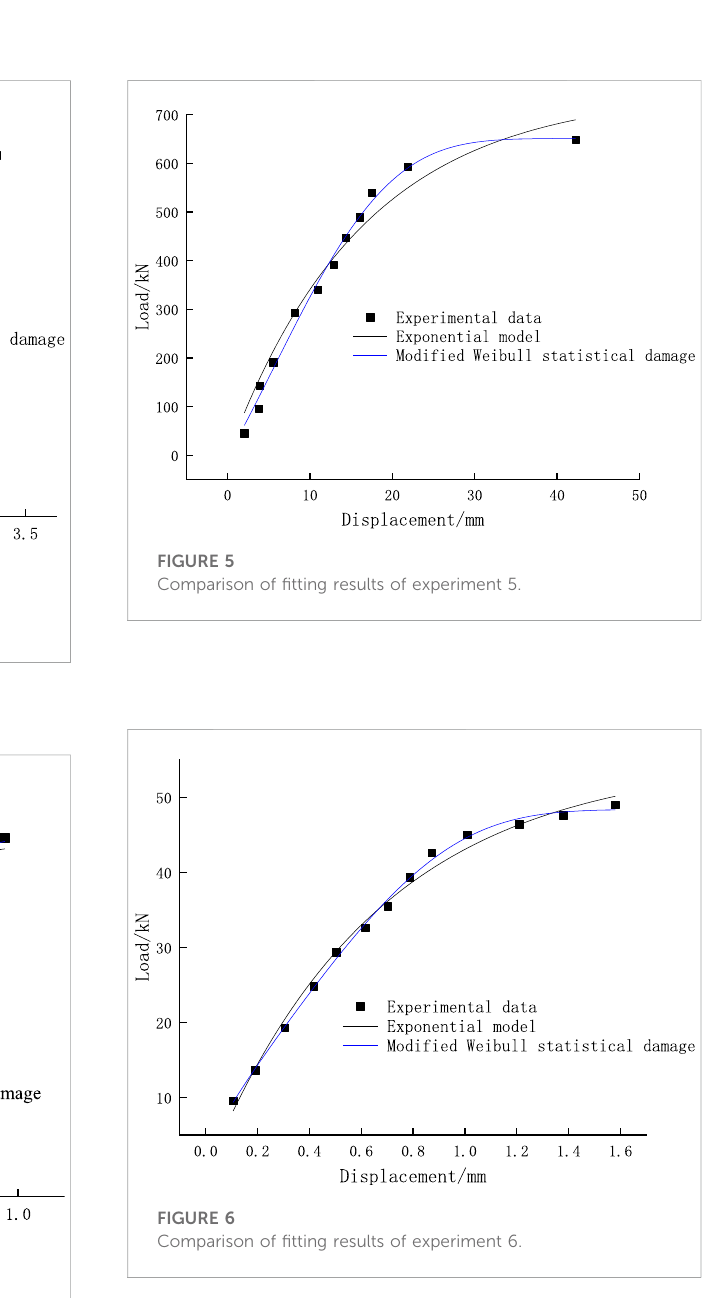
FIGURE 4 Comparison of fi tting results of experiment 4.